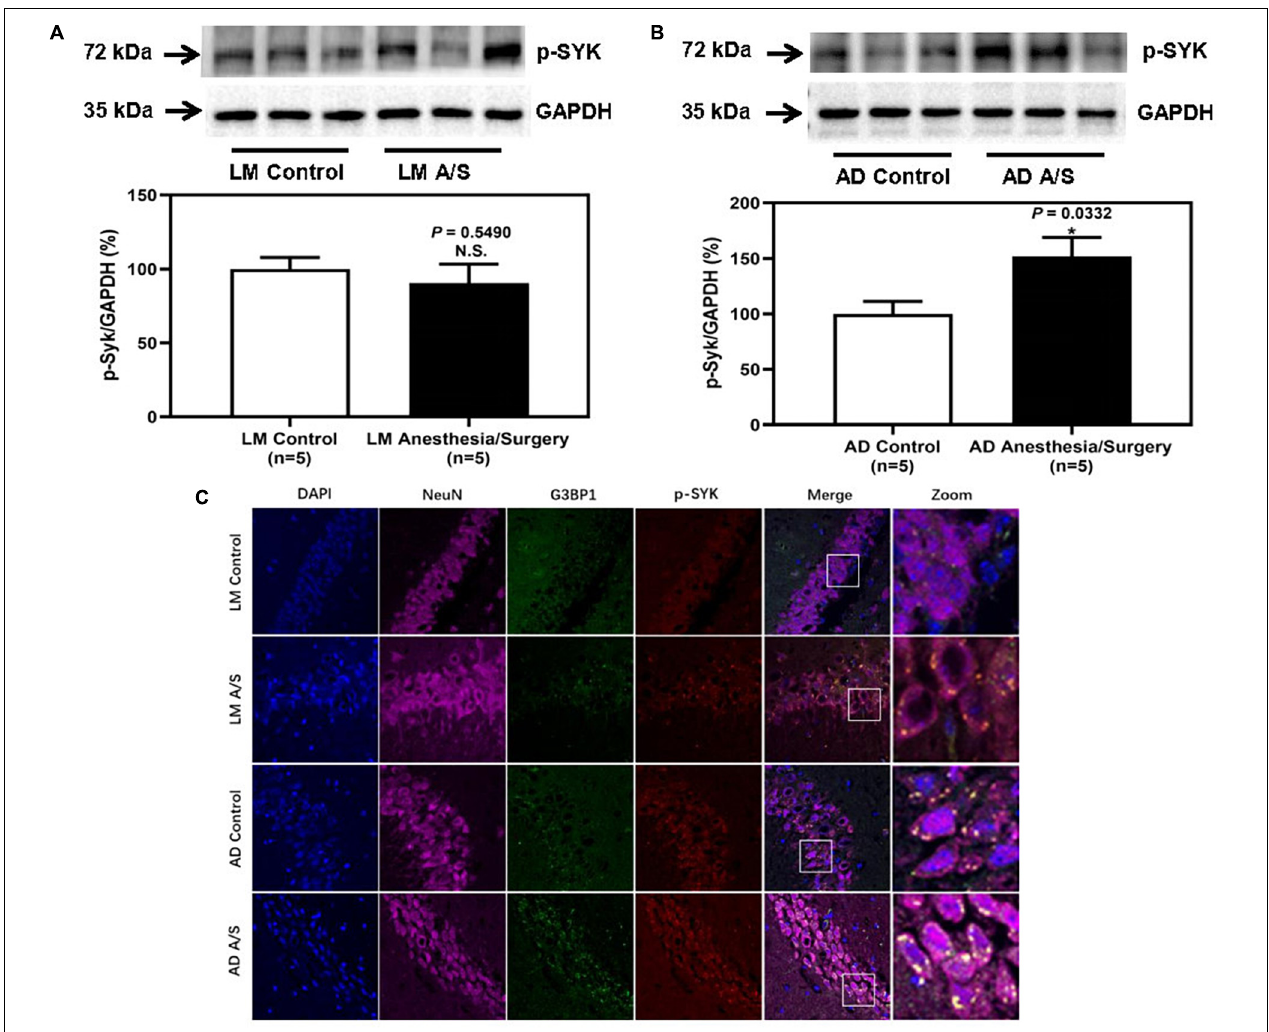
FIGURE 7 | The effect of anesthesia and surgery on the levels of p-SYK in the hippocampus of LM mice and 5XFAD Tg mice. P-SYK expression in the hippocampus of postoperative 24 h of LM mice (A) and 5XFAD Tg mice (B) in control and anesthesia/surgery group. (C) Immunostaining of p-SYK and G3BP1 positive neurons in the hippocampus of LM mice and 5XFAD Tg mice in control and anesthesia/surgery group. The hippocampus level of p-SYK was significantly increased in 5XFAD Tg mice but not LM mice at postoperative 24 h. The immunostaining of p-SYK and G3BP1 showed that p-SYK, G3BP1, and hippocampus neurons (NeuN) were colocalized. Results are expressed as mean ± SEM. Student t -test. N.S., P > 0.05 vs. untreated controls. * P < 0.05 vs. untreated